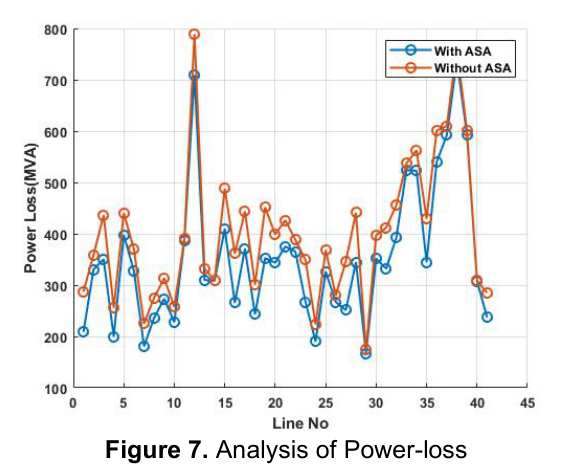
Figure 10. Comparative analysis of fitness functions of the proposed system with other existing systems From the graphs plotted analysis, it is clear that from figure 3, the proposed system severity index attains